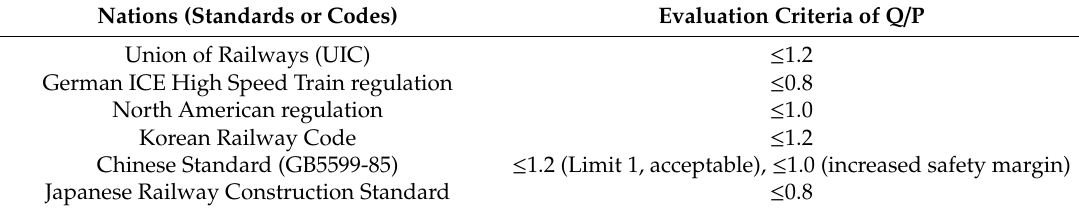
Table 1. Derailment coe ffi cient standard criteria for di ff erent nations